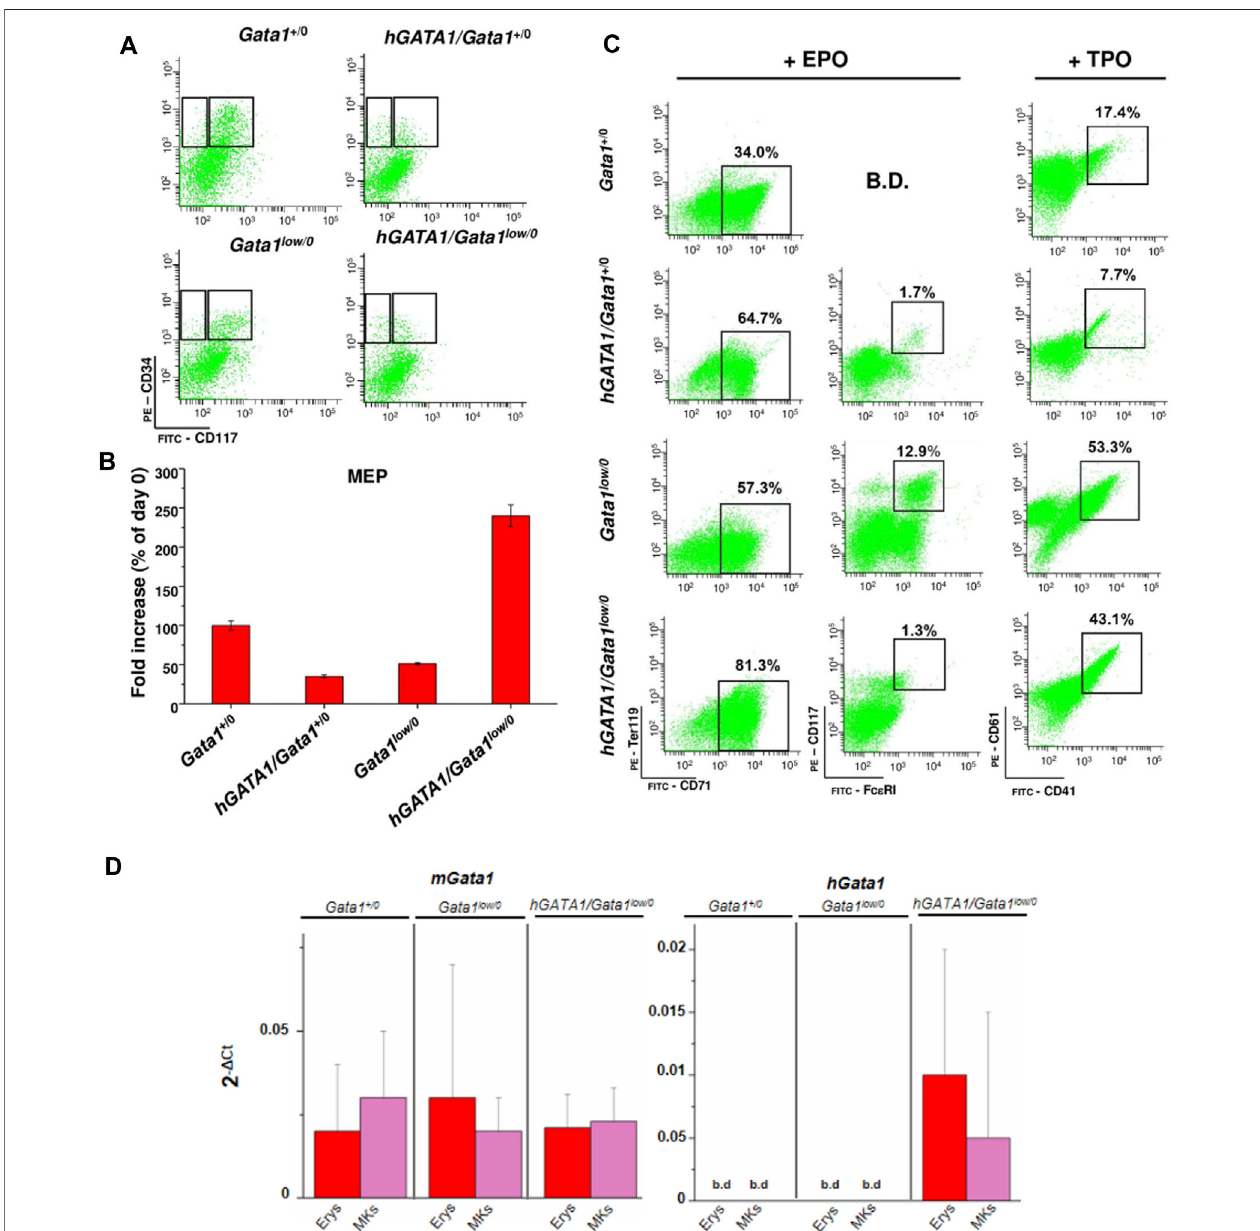
FIGURE6 | Thepresence of hGATA1 reduced number ofmastcells generated byMEPcarryingthe Gata1 low mutation in vitro , rescuing their abnormal maturation potential. (A) Representative gates used for the prospective puri fi cation of MEP (right gate) and CMP/GMP (left gate) progenitor cells from Gata1 +/0 , hGATA1/Gata1 +/0 , Gata1 low/0 and hGATA1/Gata1 low/0 mice, as indicated. (B) Fold increase by day 7 in cultures of MEP prospectively isolated from the different animal groups. Since the fold increases observed under erythroid and megakaryocytes culture conditions were the same, results obtained under the two conditions were pooled. (C) Analysis of the phenotype expressed by the progeny generated by MEP after 7 days of liquid culture under erythroid- or megakaryocyte-permissive conditions, as indicated. Erythroid, mast cells and megakaryocytes were identi fi ed according to the TER119 pos /CD71 pos , CD117 pos /Fc ε RI pos and CD41 pos /CD61 pos phenotype, respectively, as described (Ghinassi et al., 2007). B.D.: below detection. (D) Quantitative RT-PCR expression analysis of hGATA1 and murine Gata1 ( mGata1 ) mRNA in the erythroid (Erys) and megakaryocyte (MKs) progeny of MEP prospectively isolated from Gata1 +/0 , Gata1 low/0 and hGATA1 / Gata1 low/0 mice. Results are presented as Mean ( ± SD) of at least three experiments, each one with one mouse per experimental group. Statistical analyses were performed by One-way analysis of variance Dunnett ’ s Multiple Comparison Test. Results of the statistical analyses: in B and D there are no statistically signi fi cant differences among groups.